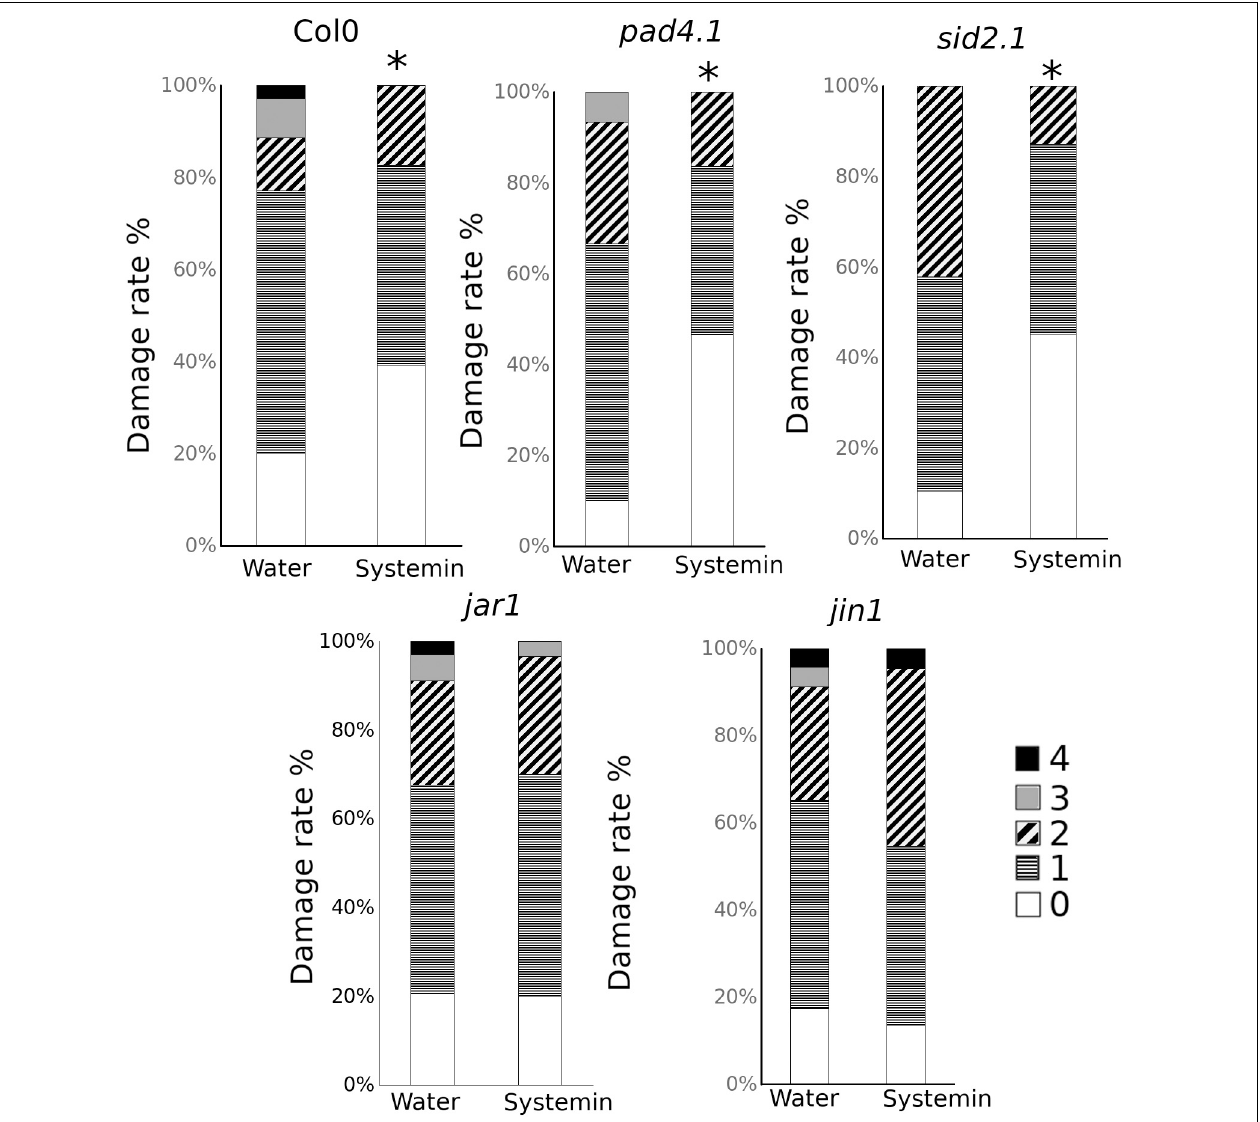
FIGURE 5 | Sys-IR assays in mutants impaired in the SA and JA-related pathways. Col-0, pad4.1 , sid2.1 , jar1, and jin1 plants were challenged with 1 µ l droplets of 5 × 10E3 spores/ml of P. cucumerina BMM 24 h after treatment with 0.1 nM Systemin. Infection levels were quantified 5 days after inoculation by a disease rating in trypan blue stained leaves, measured as a percentage of the infected leaf surface. Colors mean % of diseased leaves in a scale (0 = healthy leaves; 1 = leaves with less than 25% of diseased surface; 2 = leaves with 25–50%; 3 = leaves with 50–75% of the diseased surface, 4 = leaves with more than 75% of the surface diseased). Asterisks mean statistical significant differences; T -test; P < 0.05, n = 12). The experiment had 12 plants per treatment and was repeated at least three times with similar